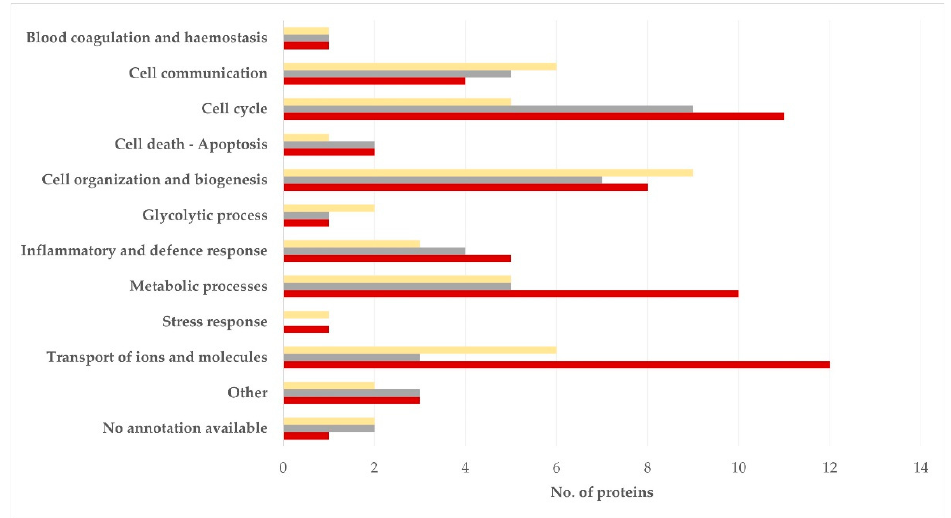
Figure 3. Biological processes in which proteins detected in blood plasma (dark red), semen sperm- rich fraction (grey), and semen prostatic fraction (yellow) from dogs were involved (protein identi- fication by LC-MS/MS).